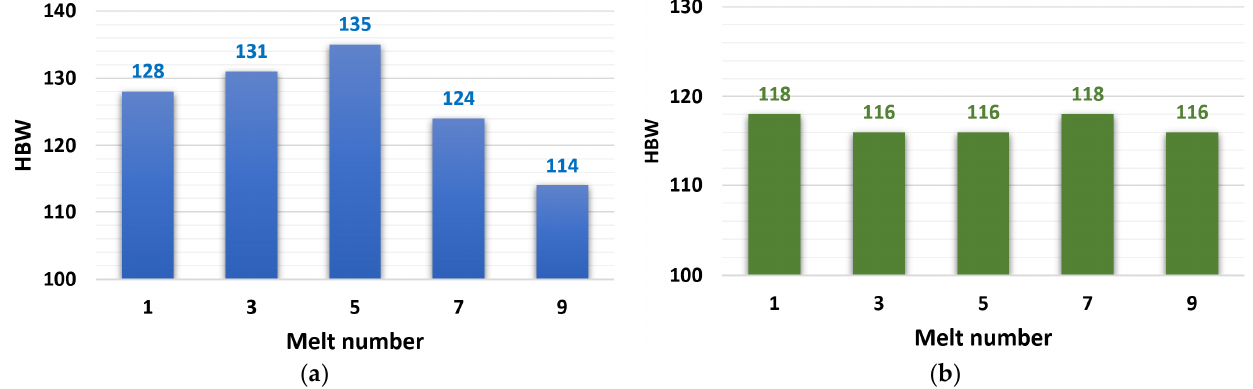
Figure 6. Dependence of ductility on the number of remelts: ( a ) ZnAl4Cu3-P1 to P9 alloys and ( b ) ZnAl4Cu3 with 3 wt.% Cd addition C1 to C9 alloys.